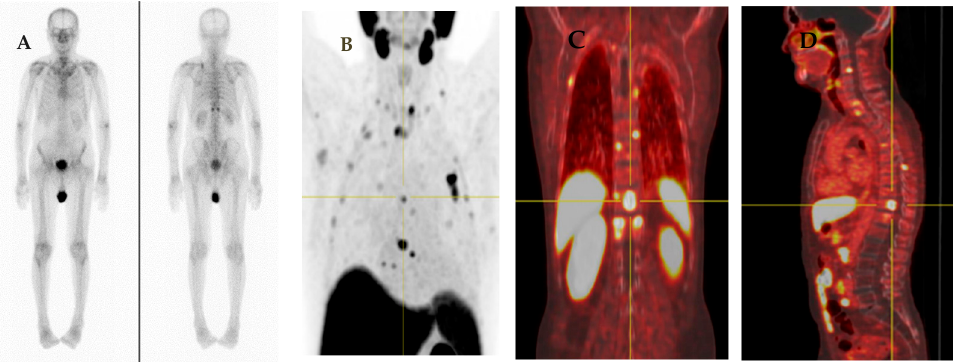
Figure 2. A 74-year-old man with adenocarcinoma of prostate gland (Gleason score 5 + 4 = 9) S/P radical prostatectomy with bilateral orchidectomy, developed rising serum PSA with level of 1.2 ng/mL which was suspected of BCR. His bone scan revealed equivocal lesions at left scapula, T8, and 12 vertebrae ( A ). He also performed 18 F-PSMA PET/CT for evaluating BCR. There are multiple PSMA-avid lesions on MIP image ( B ) associated with multiple PSMA-avid mixed osteolytic and blastic metastases at multiple levels of vertebrae, both scapulae and multiple bilateral ribs as seen on coronal PET ( C ) and sagittal PET ( D ) images.